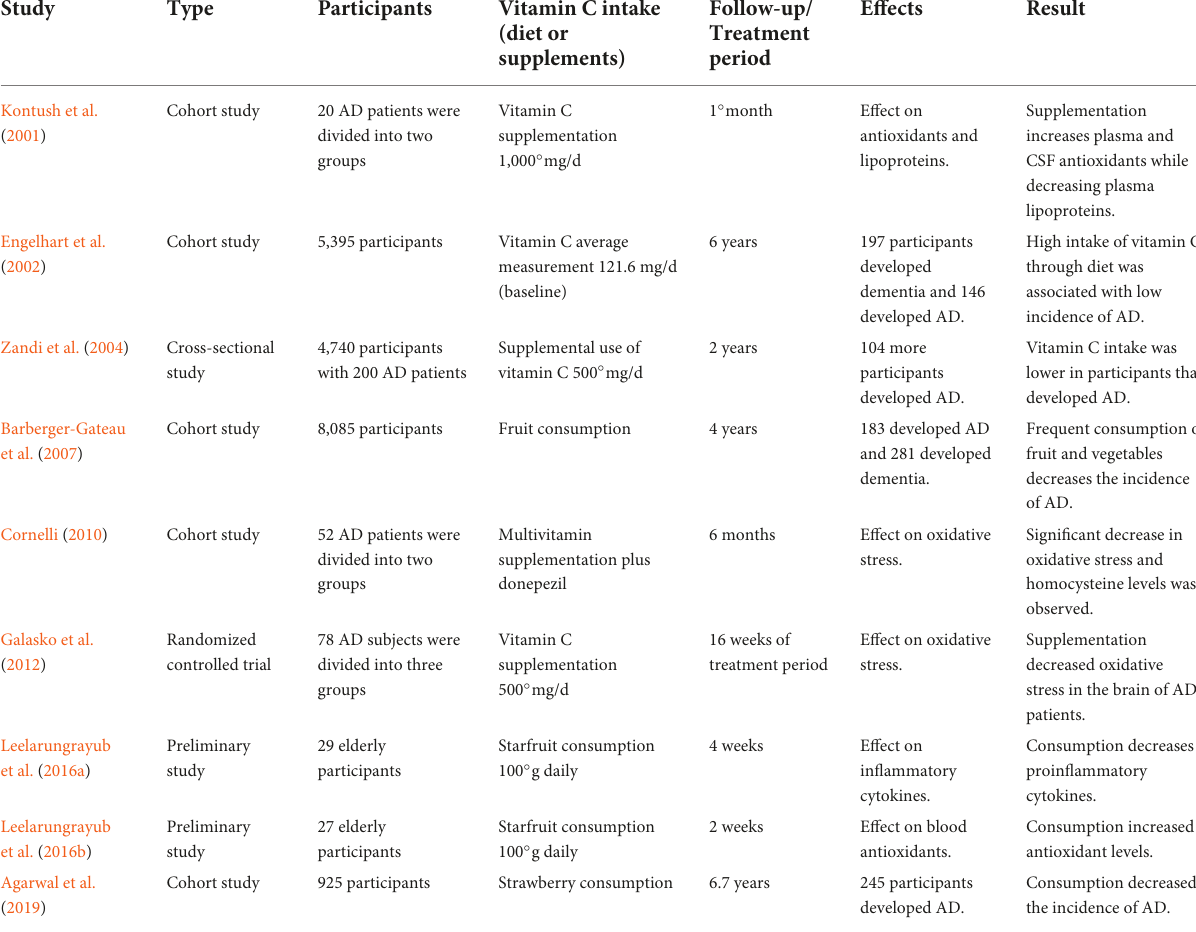
TABLE 2 Interventional studies on the status of vitamin C and Alzheimer’s disease